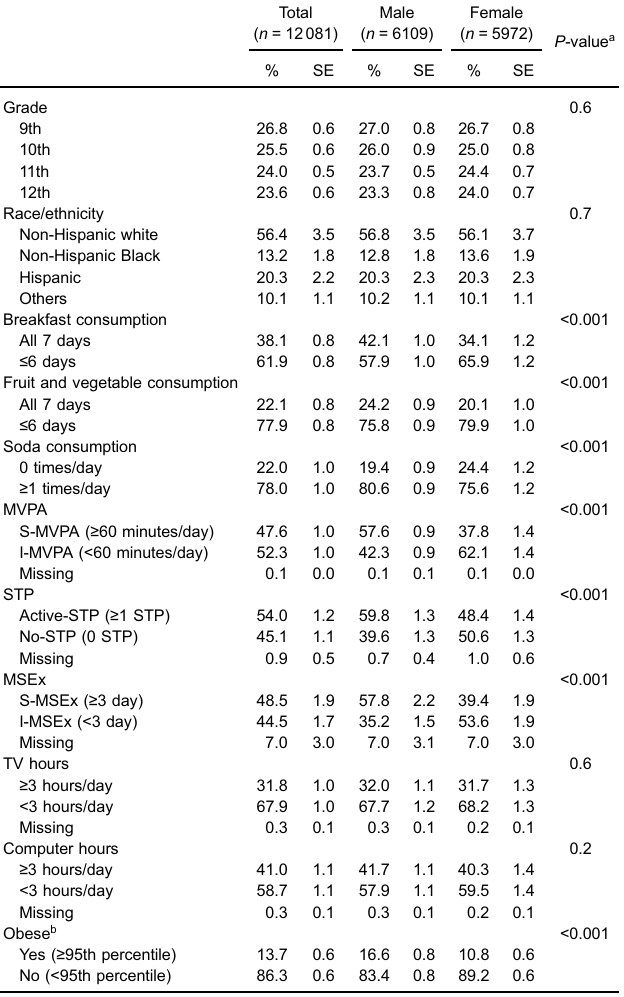
Table 1. Descriptive statistics of study variables among US adolescents